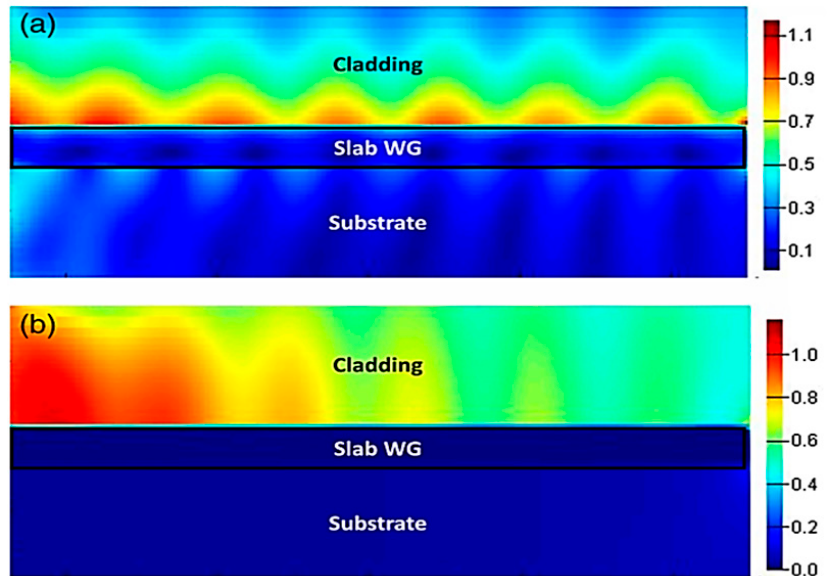
Figure 17. Comparison between the confinement capability for a test length of 400 nm for a ( a ) dopped-silicon slab and ( b ) silver slab on a SiO 2 . The total propagation distance is 10 µ m. Reprinted with permission from Ref. [103].